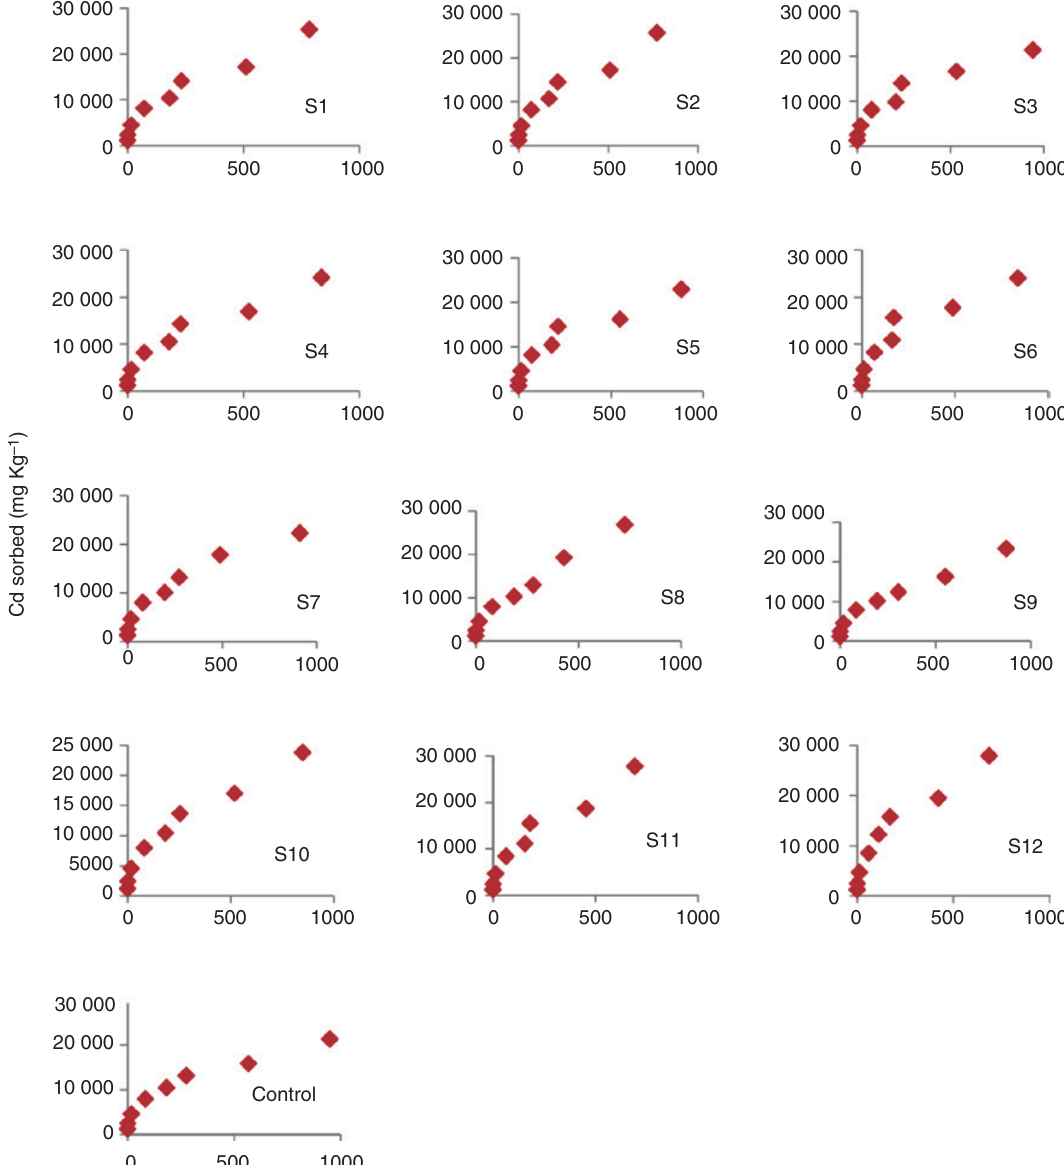
Equilibrium Cd concentration (mg l –1 )